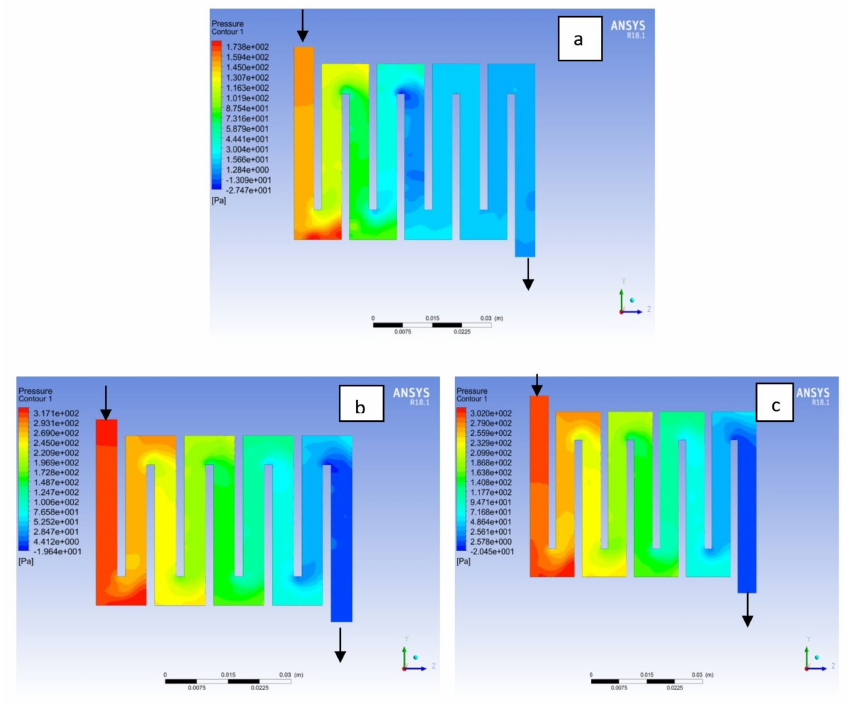
Figure 14. Pressure distribution at the anode region (GDL/CL) for each material with temperature